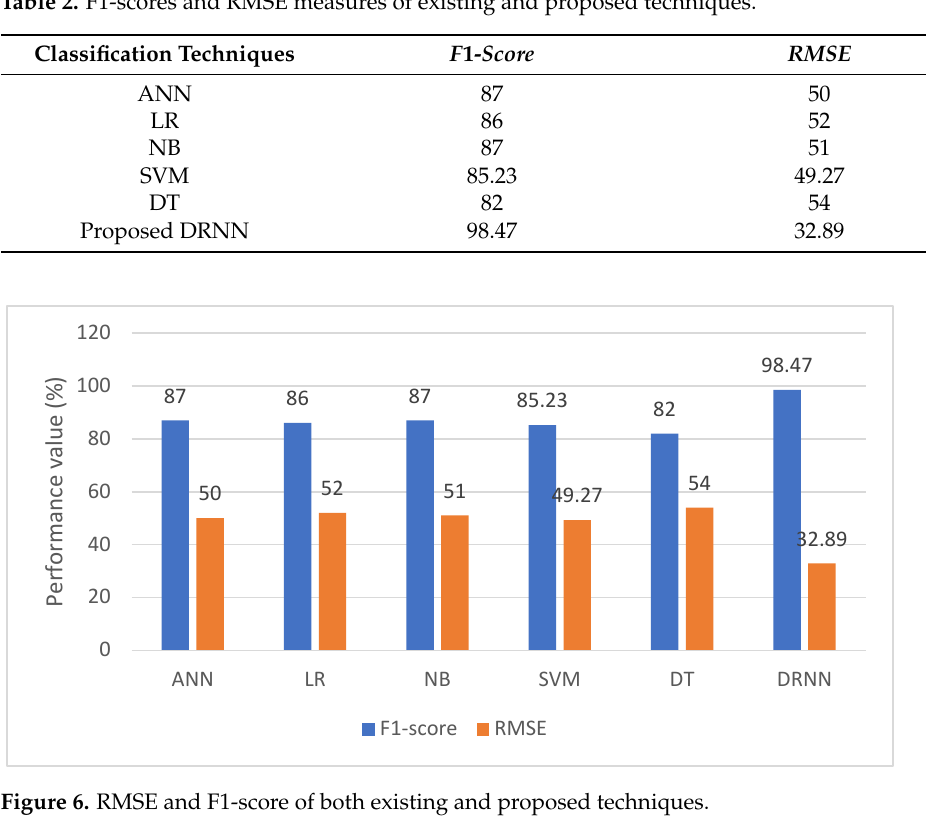
Table 3. Prediction performance under various sessions.